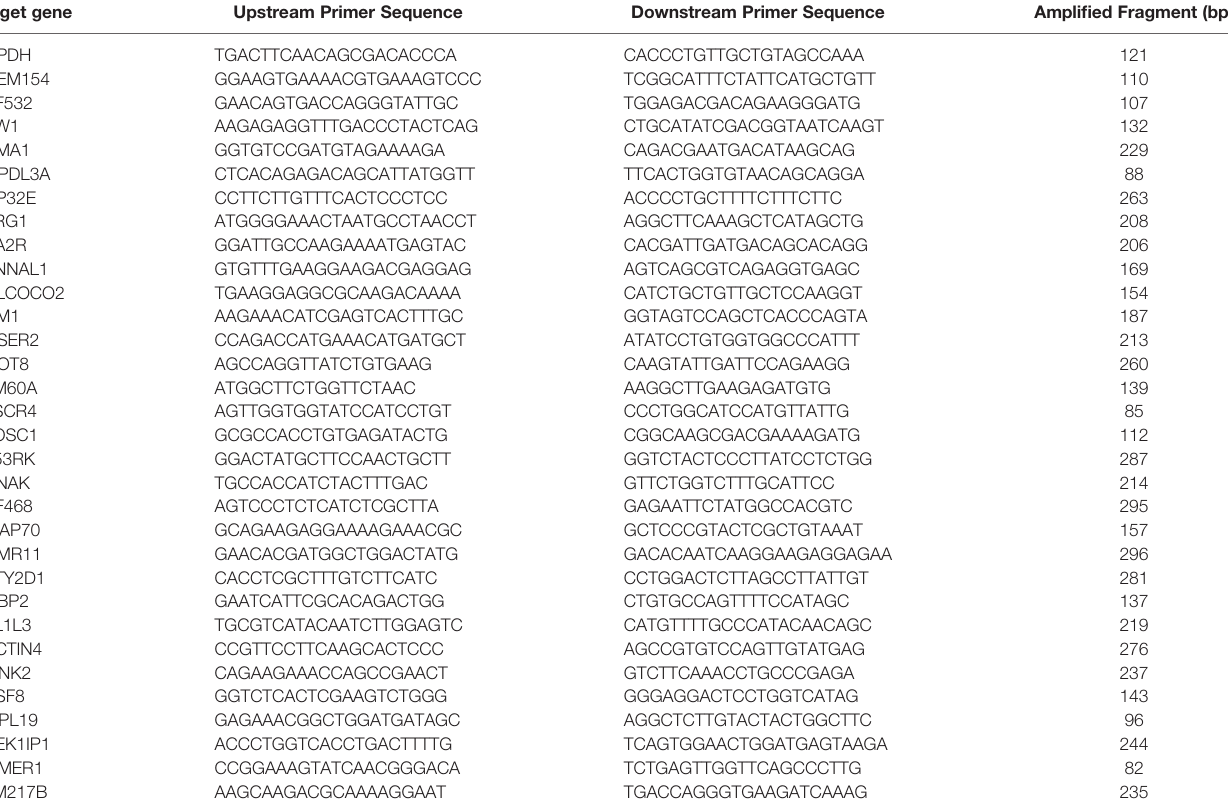
TABLE 2 | Primers designed to validate differentially expressed